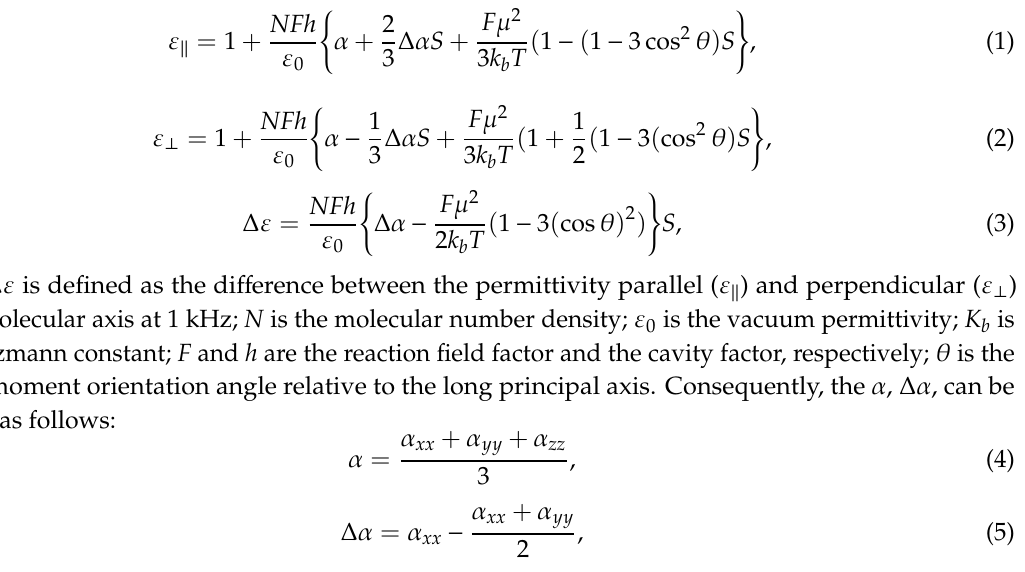
Figure 1e. The γ of the LC mixtures were measured by the transient current method [24]. The pretilt ◦ angles of the LC cells were below 3 measured by the crystal rotation method [25]. The ∆ n of the LC cells were derived from the phase retardation technique [26]. The polar anchoring energies of the LC − 4 cells remained at a constant of ~1.1 × 10 J / m 2 measured by the high electric field techniques [27]. The dielectric spectra of the LC cells were carried out by LCR meter (Hioki 3532-50, Donho Ltd., Taipei, Taiwan) with an applied alternating current (AC) field of 0.01 V / µ m at frequencies from 42 to 5 MHz. As shown in Figure 2, the optimized geometries of 5CB, BNA, M2C4N, 5CB + BNA, and